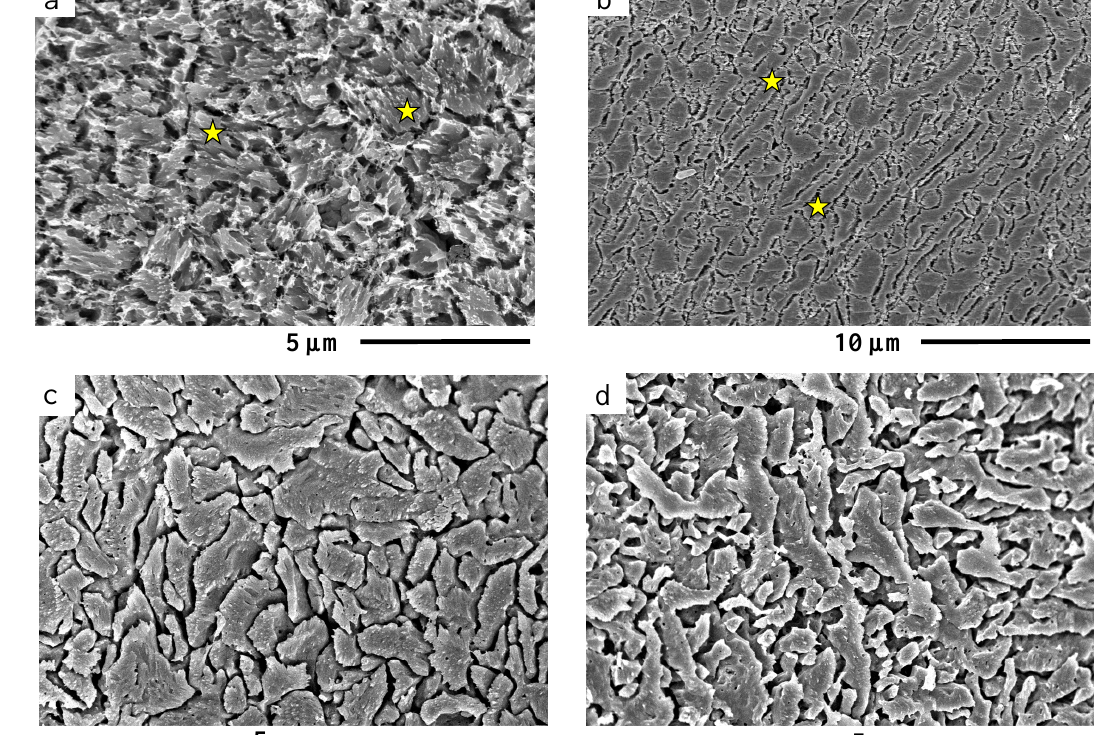
Figure 4. SEM micrographs of cut, microtome-polished, etched, and critical-point-dried surfaces of experimentally altered Arctica islandica shell materials: (a, c) outer shell layer and (b, d) inner shell layer. Etching occurred for 180s and was applied for the visualisation of the spatial distribution of (glutaraldehyde-stabilised) biopolymers within the shell; 10mM NaCl + 10mM MgCl 2 aqueous solution (burial fluid) was used for alteration at 100 ◦ C for 28 days (a, b) and at 175 ◦ C for 7 days (c, d) . Yellow stars in (a) and (b) indicate mineral